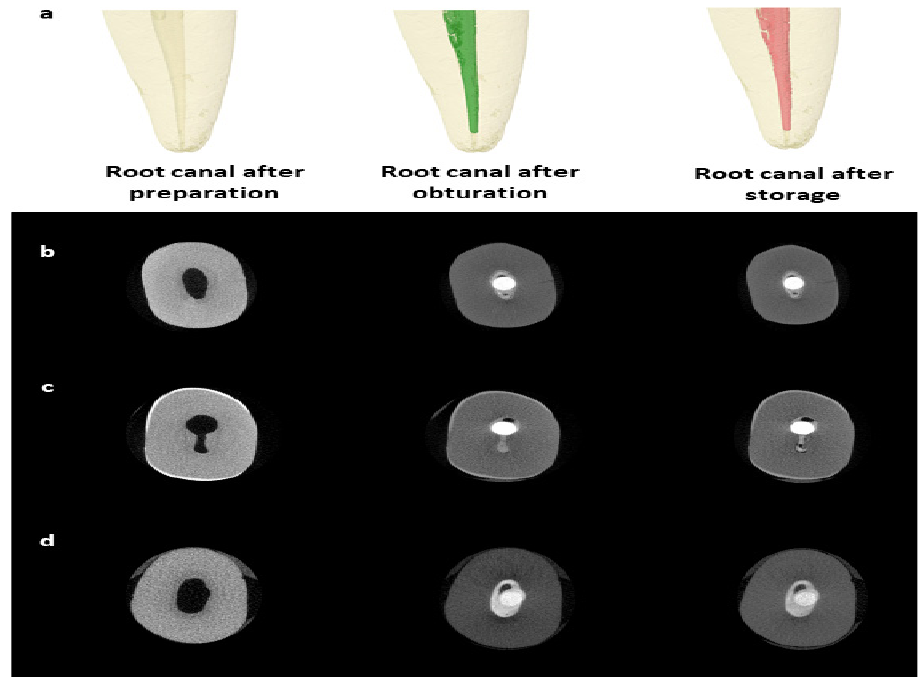
Figure 1. Micro-CT imaging for the teeth. Representative micro-CT reconstructed images for a tooth before obturation, post-obturation, and after 8-week storage in a phosphate-rich medium ( a ). Representative micro-CT slices for root canals filled with BioRoot RCS ( b ), MTA Fillapex ( c ), and Bio-C Sealer ( d ) with a single GP cone.